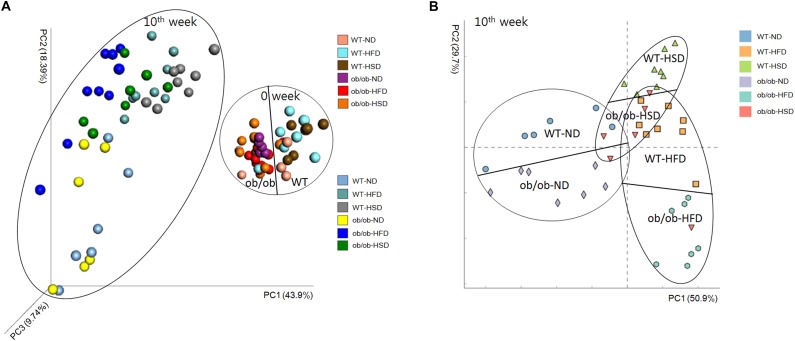
Weighted Unifrac Principal coordinate analysis chart. At the start and end of the experiment, mice fecal samples were collected and the microbial communities were analyzed by 16S rRNA gene sequencing as described in the see section “Materials and Methods”. (A) Both week 0 and week 10 and (B) only week 10 data were analyzed by the Weighted Unifrac PCoA method and plotted using XLSTAT to further evaluate the similarity between bacterial communities.